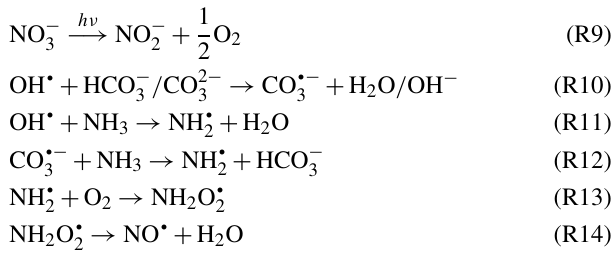
Table 1. Photoproduction rates ( R ), methods, average NO concentrations, NO −